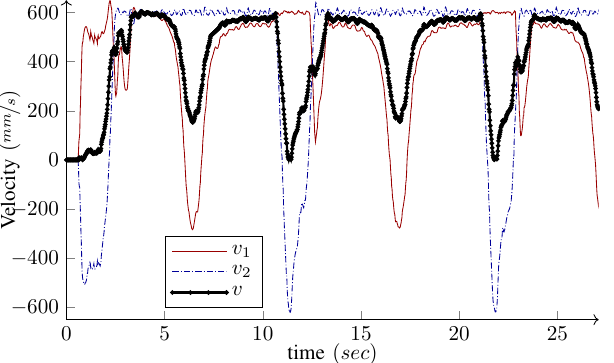
Figure 11. Experiment : Driving velocities v 1 and v 2 , and the base speed v , for the bounded velocity path-following of LabRat ( δ = ( 2,0 )